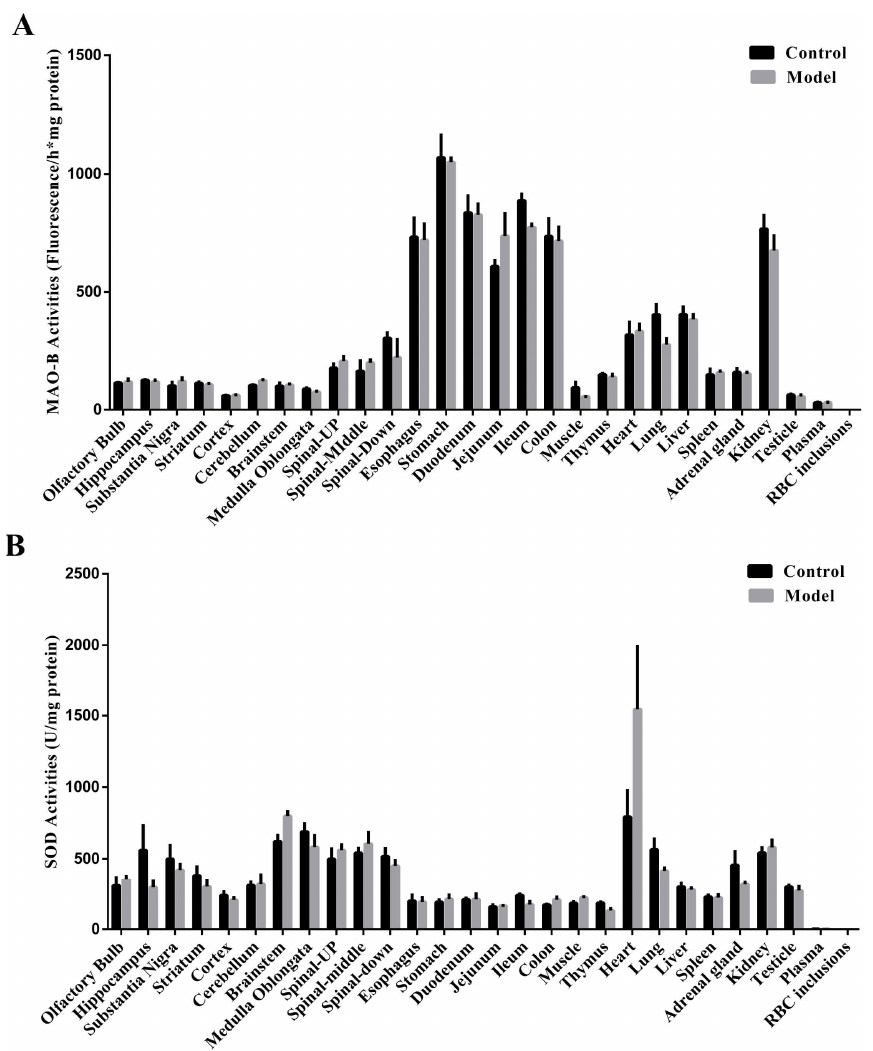
Figure 7. Naturally high activities of MAO-B and low activities of SOD in the stomach. ( A ) MAO-B and ( B ) SOD activities across different CNS tissues, gastrointestinal organs, blood components, and other critical peripheral organs are shown ( n = 3). The data are presented as the means ± SEM. Next, we measured ROS production levels in the SN, the STR, the colon, the ventral half of the stomach, and the kidney 3 h after a single injection of MPTP (40 mg/kg) (Figure 8A). Only 3 h after MPTP injection, ROS levels in the SN of the model group increased considerably but not significantly. MPTP induced a significant increase ( p < 0.05) of ROS production in the stomach, indicating that the stomach is more vulnerable to MPTP inva- sion. Furthermore, immunofluorescence results showed that the intensity of 4-hy- droxynonenal (4-HNE), a biomarker for cell damage due to oxidative stress, increased in some stomach EGCs after 3 h of exposure to MPTP (Figure 8B).